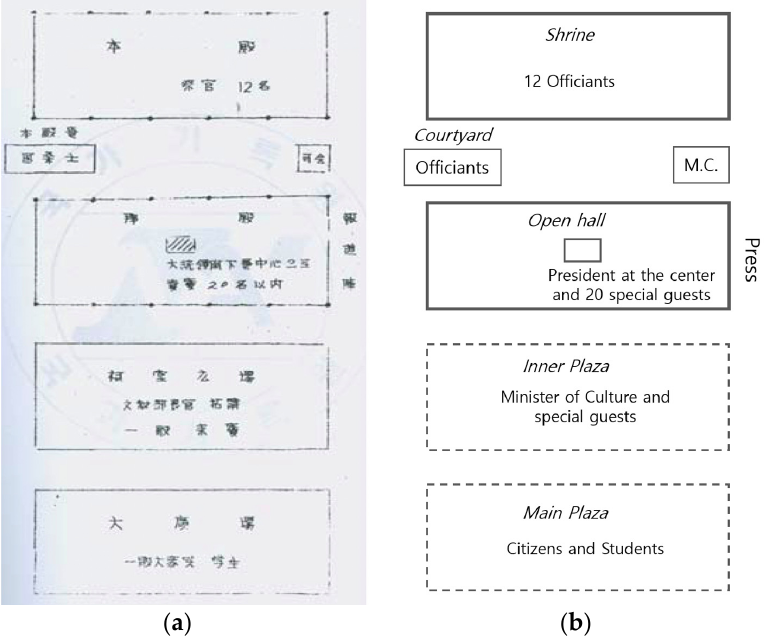
Figure 11. Organization for the Ritual Ceremony of Admiral Yi’s Birthday in 1967 (( a ): diagram of the original document, National Archives of Korea) (( b ): translated and drawn by the author). Figure 12. Two Representative Types of Korean Roofs ( a ) Hipped-and-Gabled Roof (Daeungjeon Hall, Bulguksa Temple) ( b ) Gabled Roof (Previous Main Hall of Hyeonchungsa Built in 1932) (Source: Cultural Heritage Administration, Asan City).